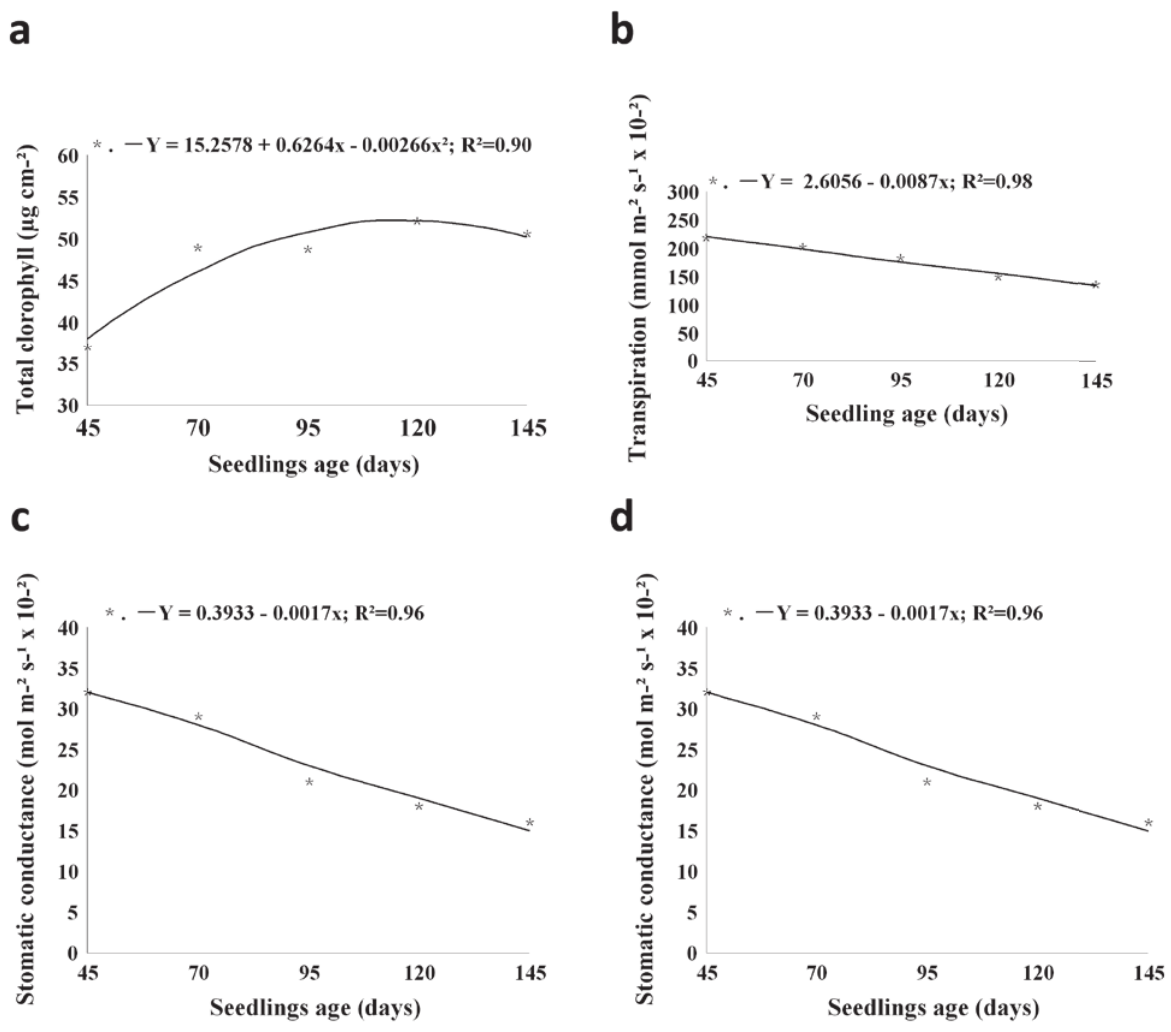
Figure 2 - Total chlorophyll (a) , transpiration (b) , photosynthesis (c) and stomatic conductance (d) of Myracrodruon urundeuva Allemão seedlings due to their